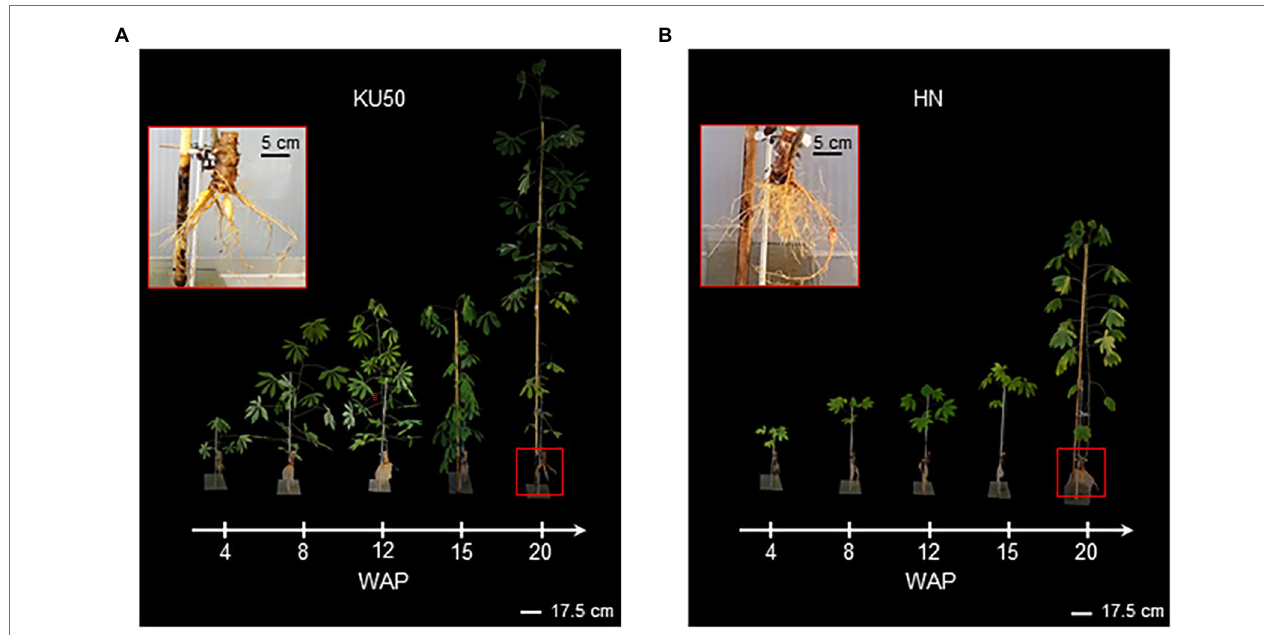
FIGURE 5 | Growth and development of (A) KU50 and (B) HN cassava varieties grown under greenhouse conditions during 4–20 WAP. The top left panel shows the root structure of each cassava cultivar at 20